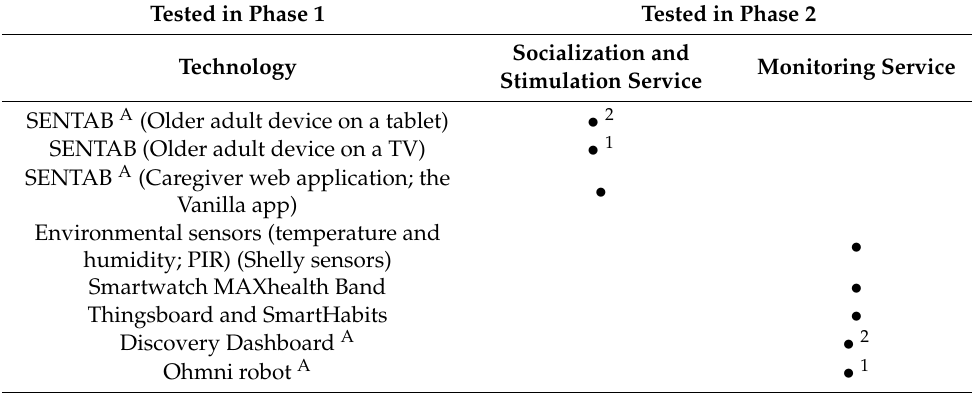
Table 3. List of technologies tested in the two pre-validation phases. Within Phase 1, the technol- ogy was tested as a standalone solution, whereas Phase 2 was focused on the evaluation of the integrated